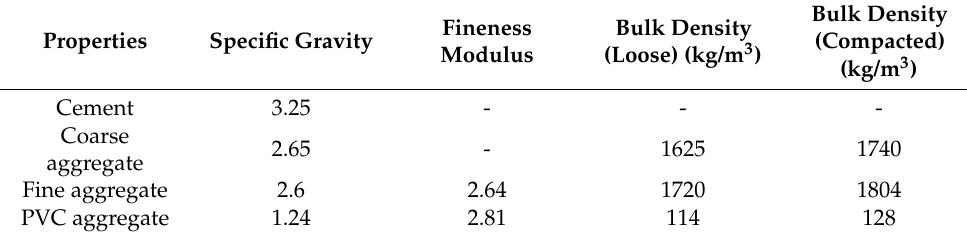
Table 3. Properties of Polyvinyl alcohol.